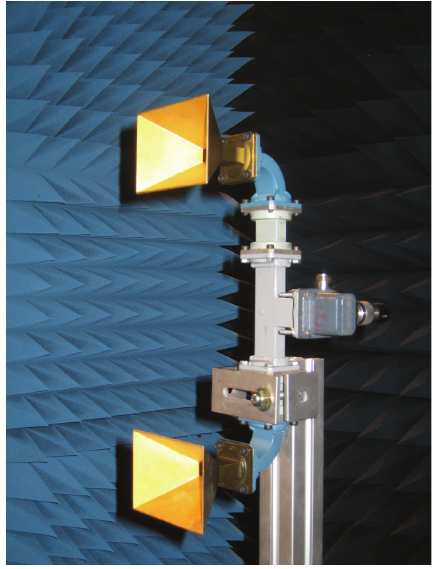
Figure 7: Photo of the vertically polarized dual